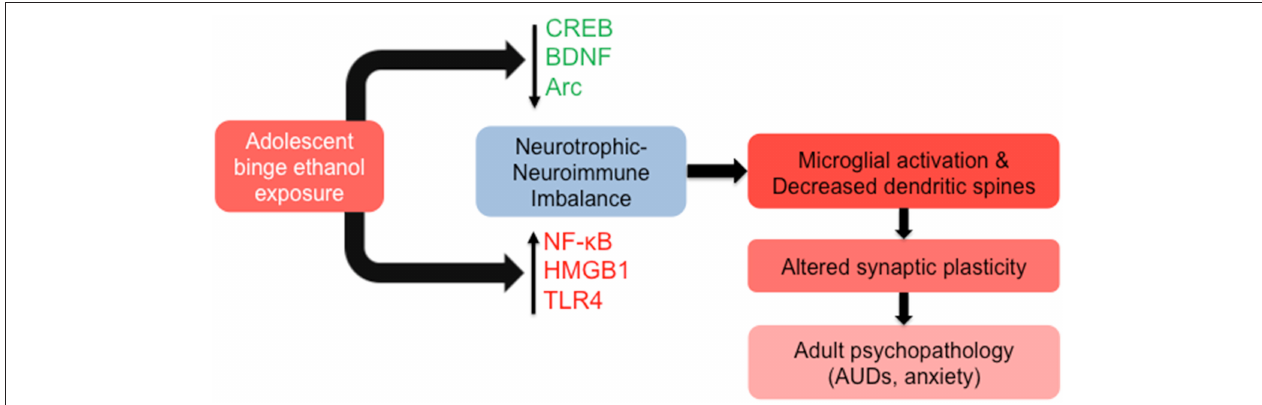
FIGURE 3 | Molecular and cellular signaling mechanisms in the brain leading to altered synaptic plasticity in adulthood after adolescent alcohol exposure. Adolescent binge alcohol exposure exerts effects in the brain long after alcohol has left the system. For example, adolescent alcohol causes a long-lasting decrease in key synaptic plasticity-related genes including cyclic AMP response element binding protein (CREB) pathway (CREB binding protein), brain-derived neurotrophic factor (BDNF), and activity-regulated cytoskeleton-associated protein (Arc). At the same time, adolescent binge alcohol exposure increases neuroimmune mediators including nuclear factor kappa-light-chain-enhancer of activated B cells (NF- κ B), high mobility group box 1 (HMGB1) and toll-like receptor 4 (TLR4). The increase in neuroimmune factors and decrease in neurotrophic factors may be responsible for molecular imbalance in the adult brain that is mediated by increased microglial activation and decreased synaptic plasticity, leading to an increased risk for alcohol use disorders (AUDs) and related psychopathology such as anxiety.